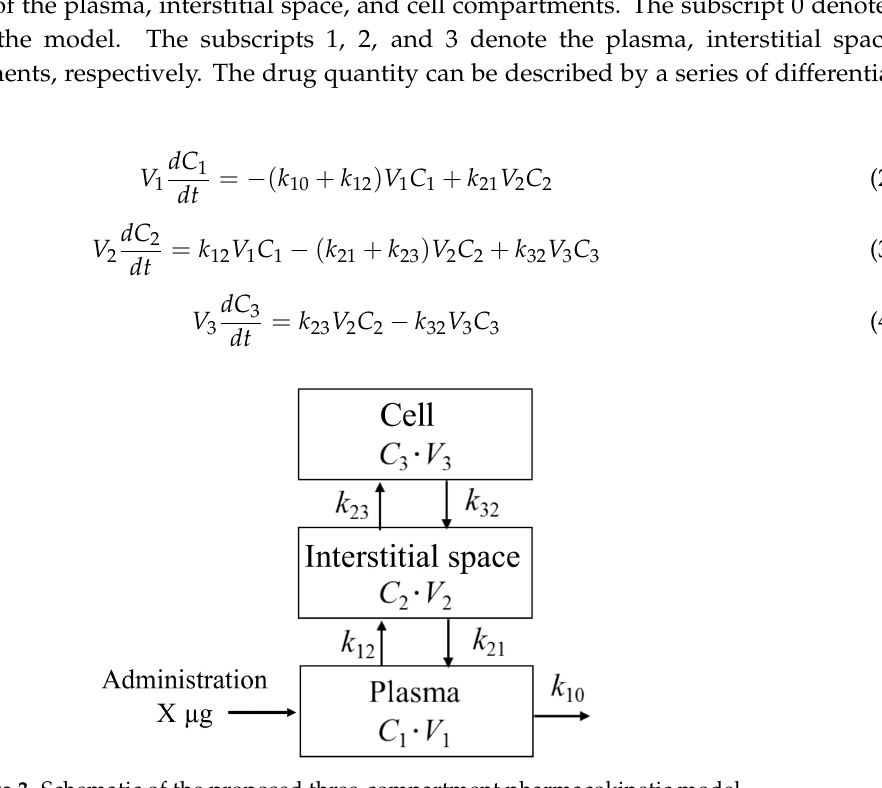
Figure 3. Schematic of the proposed three-compartment pharmacokinetic